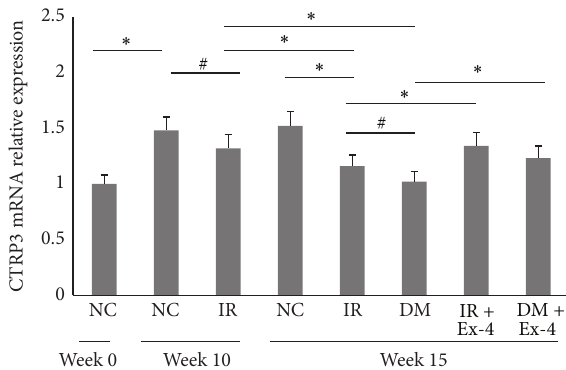
Figure 2: CTRP3 mRNA expression at the different stages of T2DM pathogenesis. NC: normal control group; IR: insulin resistance group; DM: diabetes mellitus group; IR + Ex-4: insulin resistance plus Exendin-4 treatment group; DM + Ex-4: diabetes mellitus plus Exendin-4 treatment group; ∗ 𝑃 < 0.01 , # 𝑃 < 0.05 .